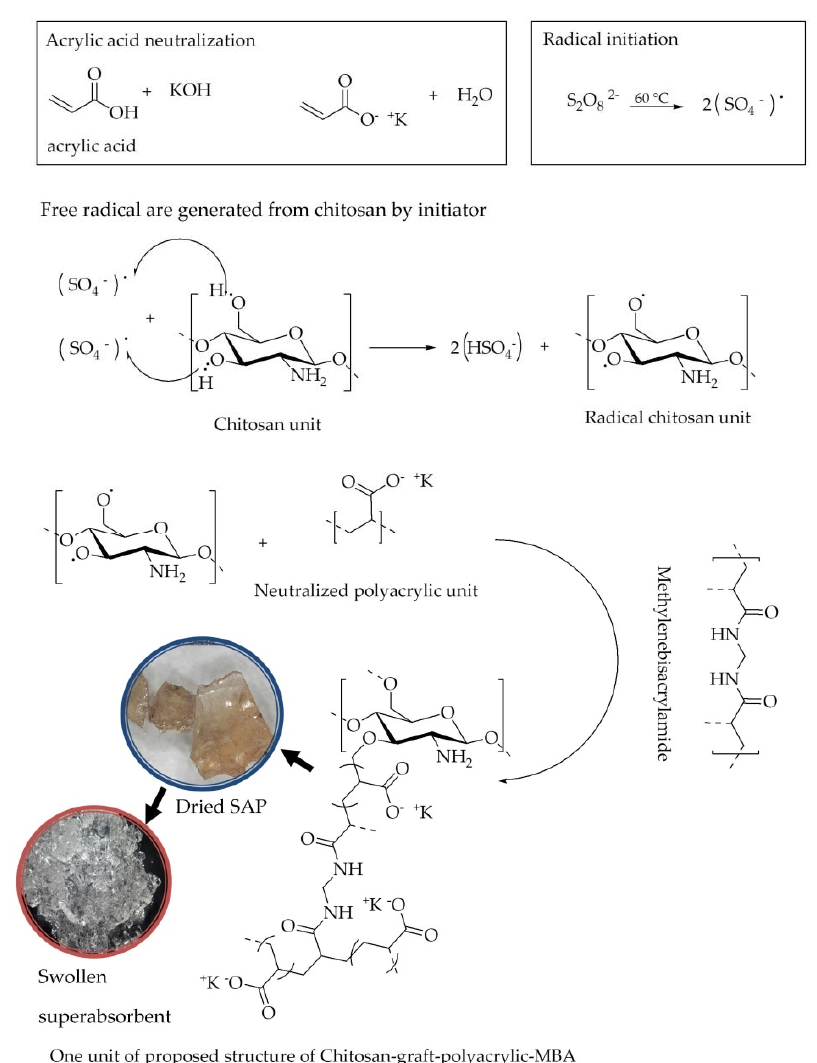
Figure 1. The proposed reaction mechanism of the synthesis process of graft polymerization of chitosan free radicals to acrylic acid with an MBA cross-linking agent.